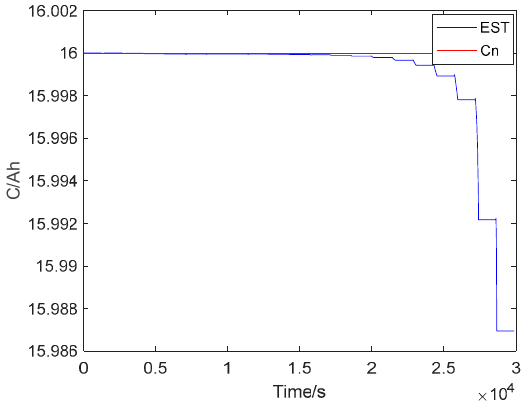
Figure 11. Capacity estimation in the CCPC tests.